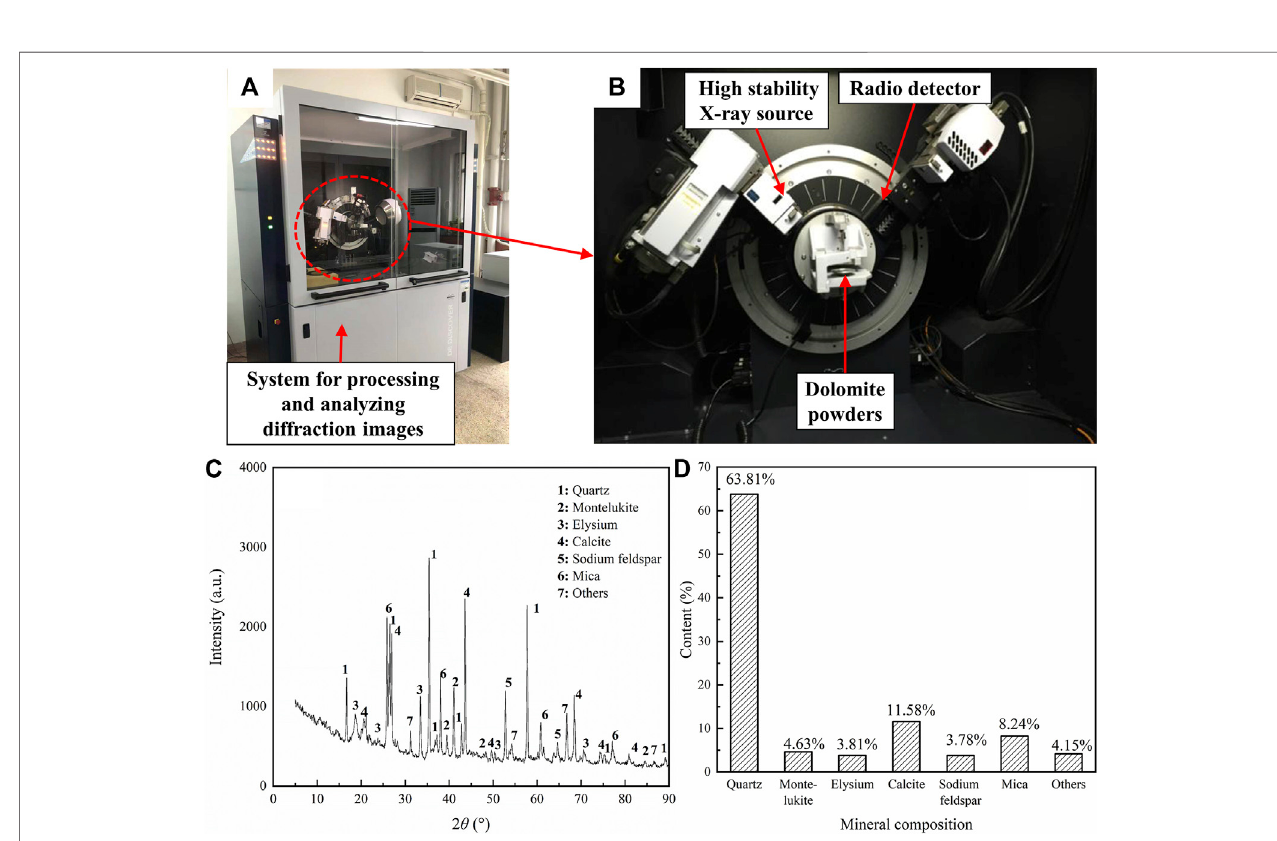
FIGURE 5 | XRD diffraction of ore pillar sample: (A) D8 advance XRD powder diffractometer; (B) Sample powder placement platform; (C) XRD spectrum of dolomite; (D) Determination result of mineral percentage content.